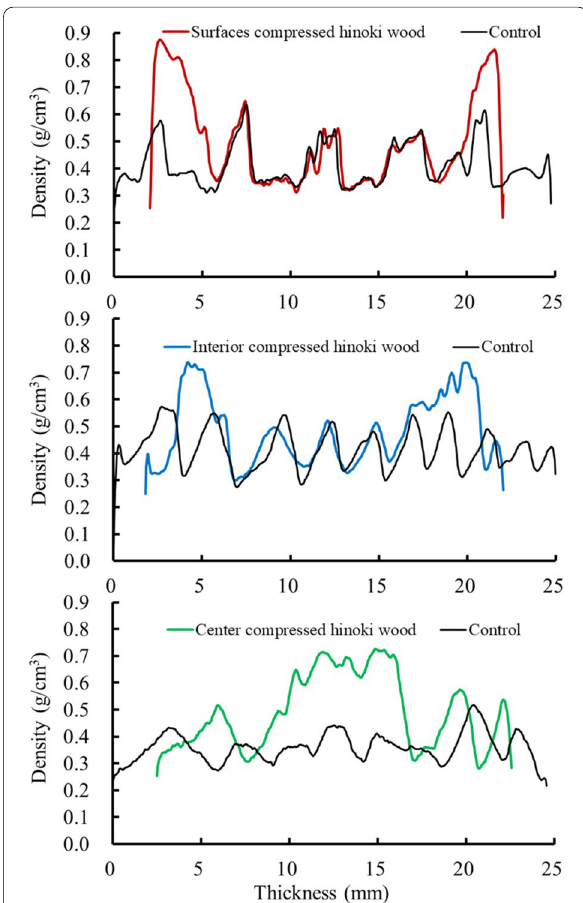
Fig. 5 Density distribution along the thickness of sandwich compressed hinoki timber (compressed from 25 to 20